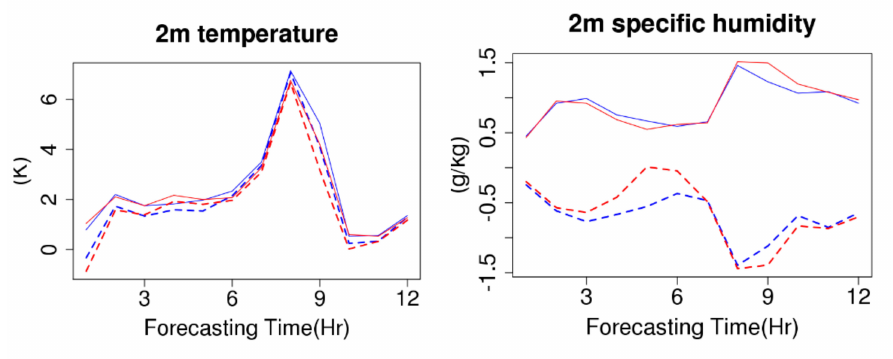
Figure 9. RMSE (solid lines) and Bias (dotted lines) for 2 m temperature and 2 m specific humidity forecasted by the control experiment (blue lines) and the MWRPS experiment (red lines) in relation to observations for the black rectangular